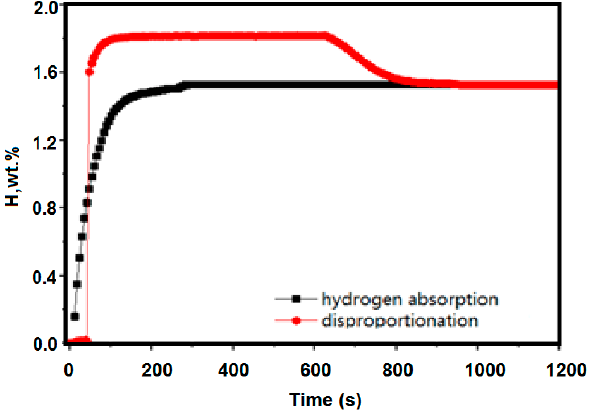
Figure 7. Disproportionation reaction curves of Zr 2 FeH 5 during 1 h hydrogen release at 300–600 °C.